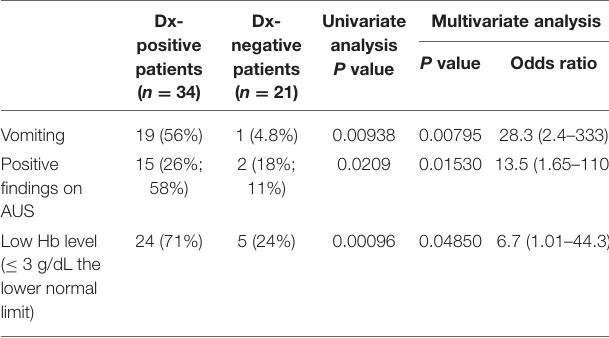
TABLE 4 | Predictive factors of a positive diagnosis via EGD in the multivariate